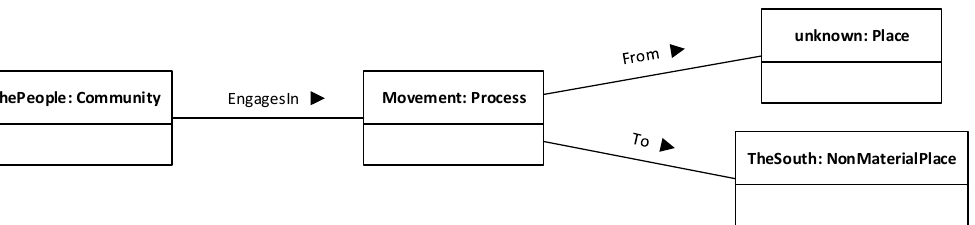
Figure 9. Domain model representing the observations made from the analysis of proposition PR24 in Figure 8.